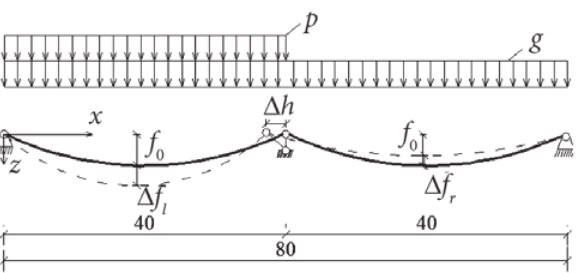
Fig. 2. Analytical model of the two-span split-type structure